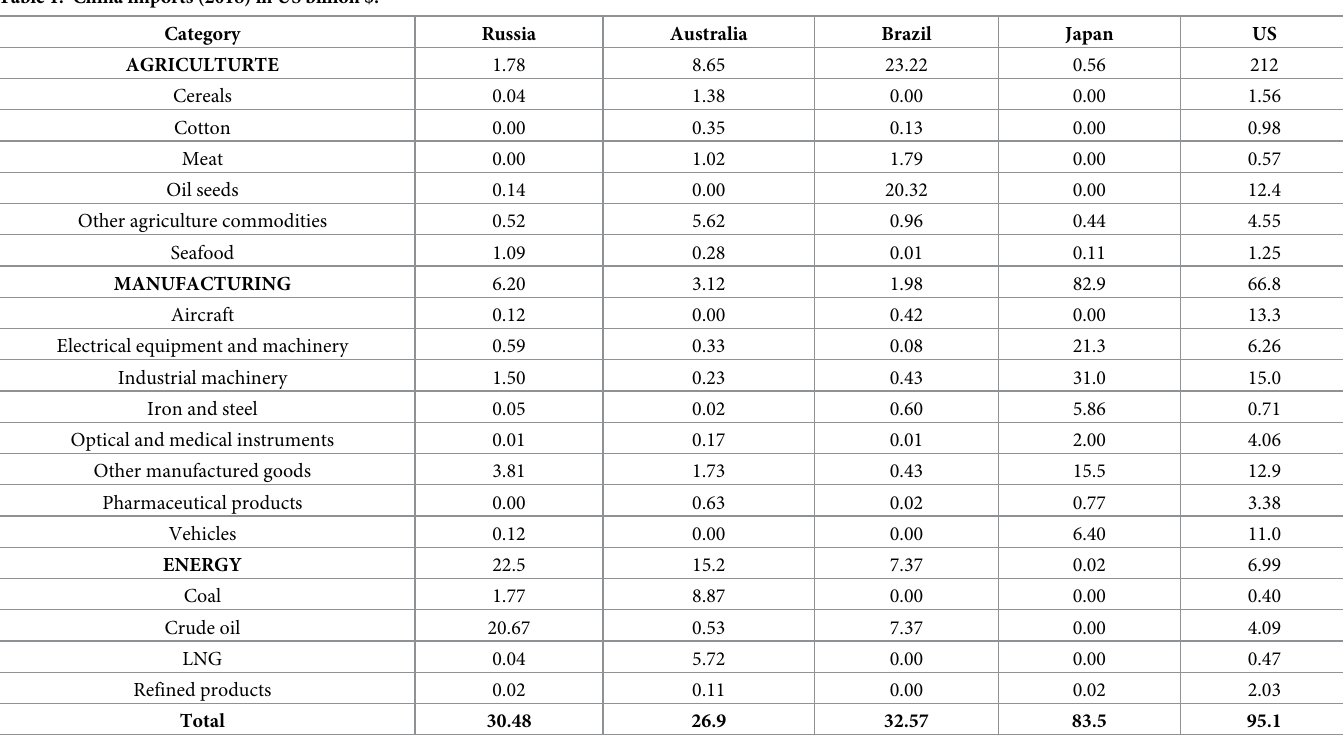
Table 1. China imports (2018) in US billion $.